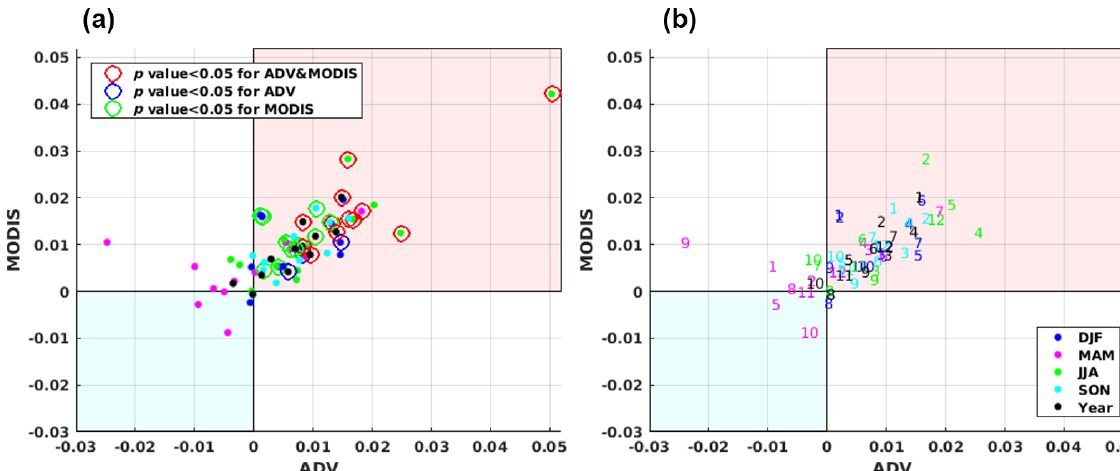
Figure 14. Scatterplot of the 2000–2011 yearly tendencies (a) derived from MODIS C6.1 DBDT vs. those derived from ATSR ADV v2.31, for China, SE China and the 10 selected areas (as specified in b ) for the yearly (black dots) and seasonally averaged AOD (colored dots, see legend). Colored circles indicate if the p value < 0.05 for both ADV and MODIS (red), for ADV only (blue) or for MODIS only